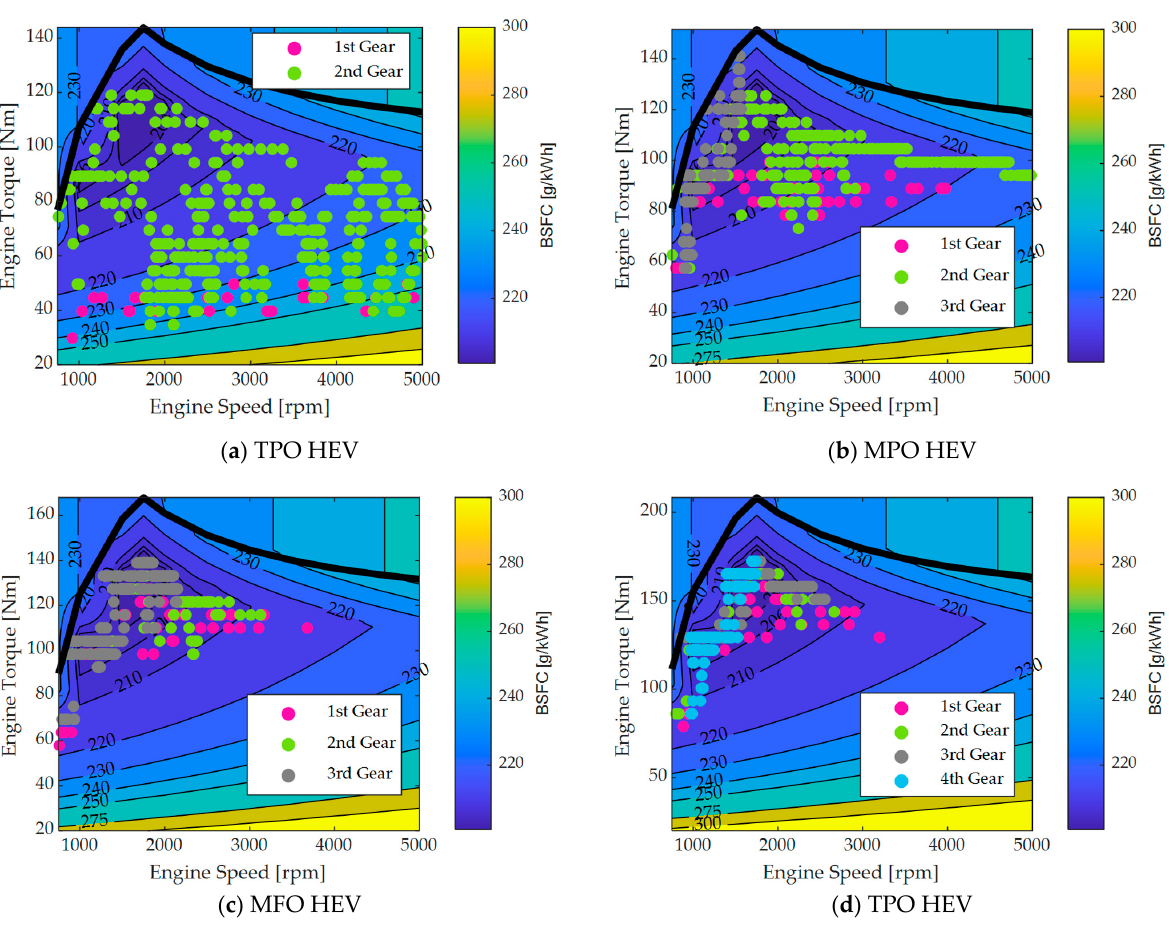
Figure 9. ICE operating point obtained in the WLTP drive mission for the ( a ) totally production-oriented, ( b ) mostly production-oriented, ( c ) mostly fuel-oriented, and ( d ) totally fuel-oriented optimal layouts. The colored map shows the brake specific fuel consumption (BSFC) areas, whereas the solid black line instead is the WOT curve.